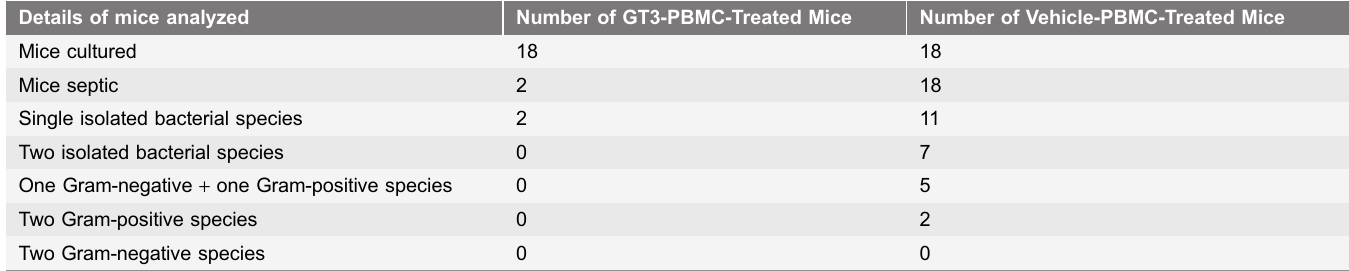
Effect of GT3-mobilized progenitor cell transfusion on the translocation of intestinal bacteria in irradiated mice To analyze the potential anti-infective effect of transfused GT3 mobilized PBMC relative to bacterial translocation across the gut bacteria to other organs, we